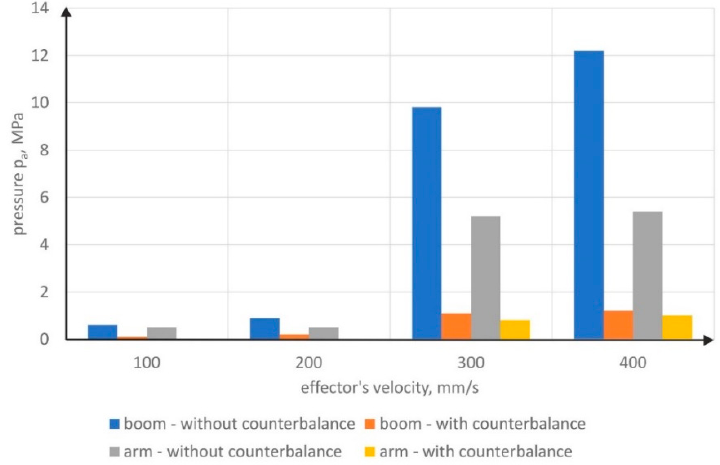
Figure 21. Pressure, p a , for different speeds of movement of the effector.